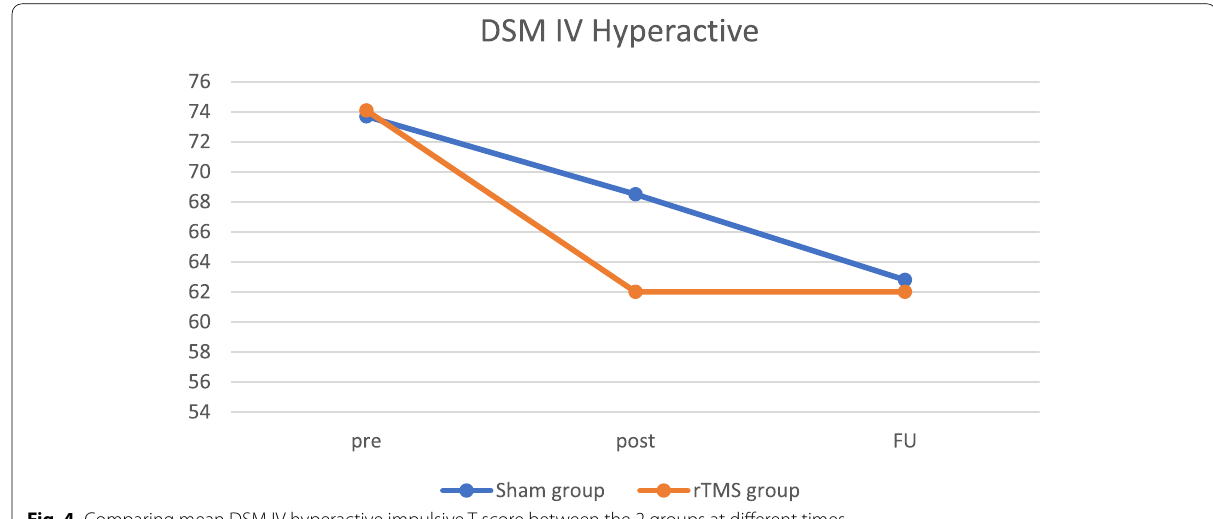
Fig. 4 Comparing mean DSM IV hyperactive impulsive T score between the 2 groups at different times